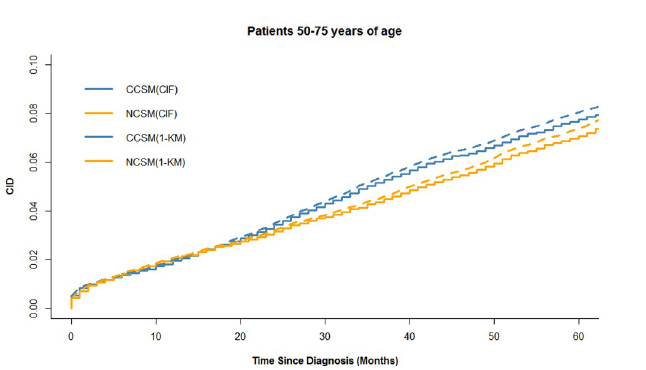
Fig 4. Cumulative incidence functions and Kaplan-Meier method estimates for patient 50–75 years of age. CCSM: colon cancer-specific mortality; NCSM: noncancer-specific mortality; CID: cumulative incidence of death; CIF: Cumulative incidence functions; KM: Kaplan-Meier